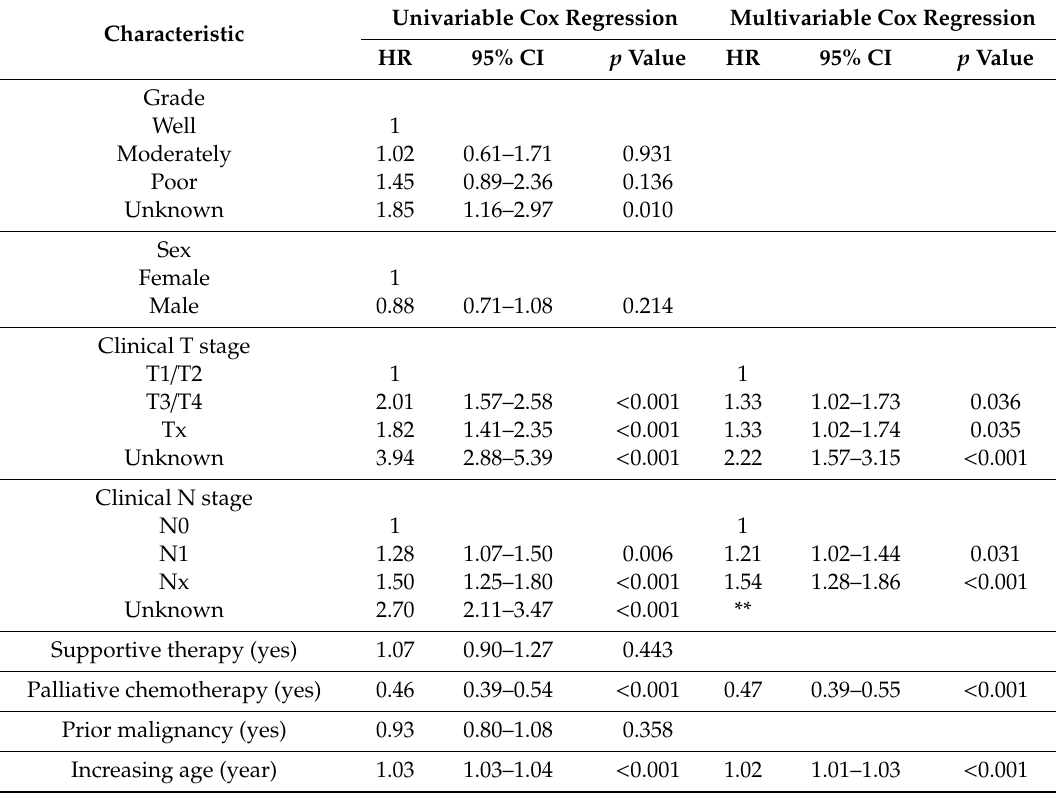
B. Prognostic factors for patients with metastatic gallbladder cancer. N =